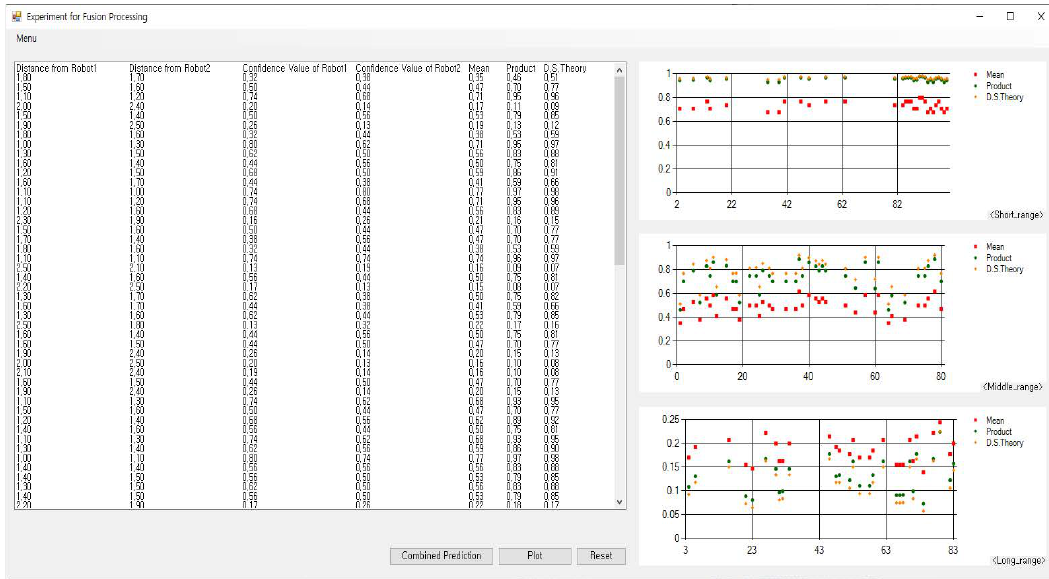
Figure 4. Experiment for individual fusion processing using mean, product, and DS theory operators. Figure 4 is divided into two parts, the situation panel on the left and the graph panel on the